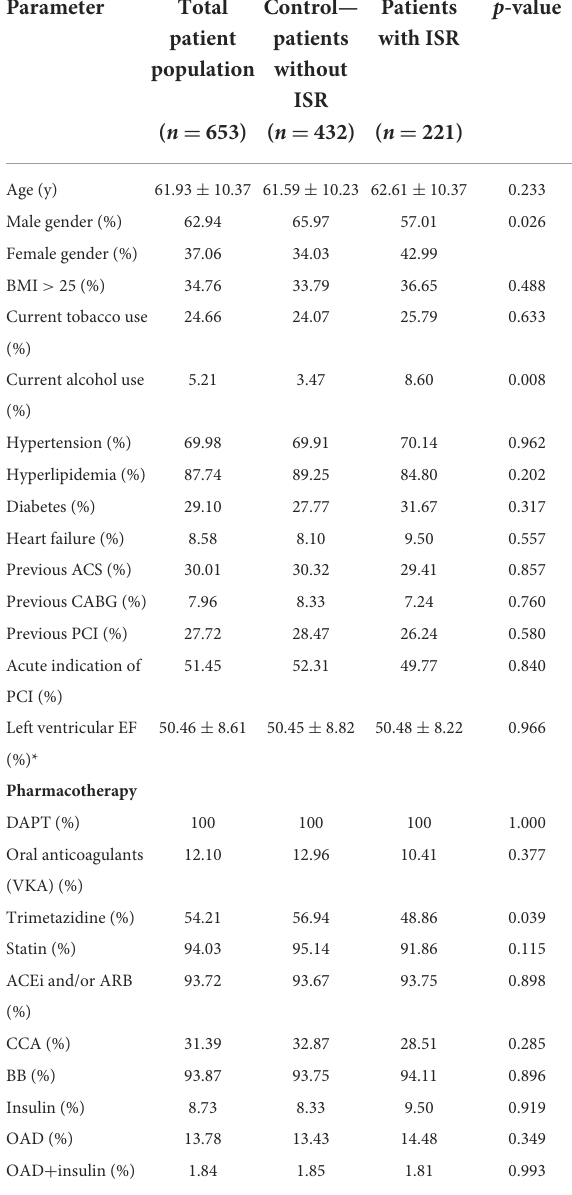
TABLE 1 Baseline clinical characteristics and medical